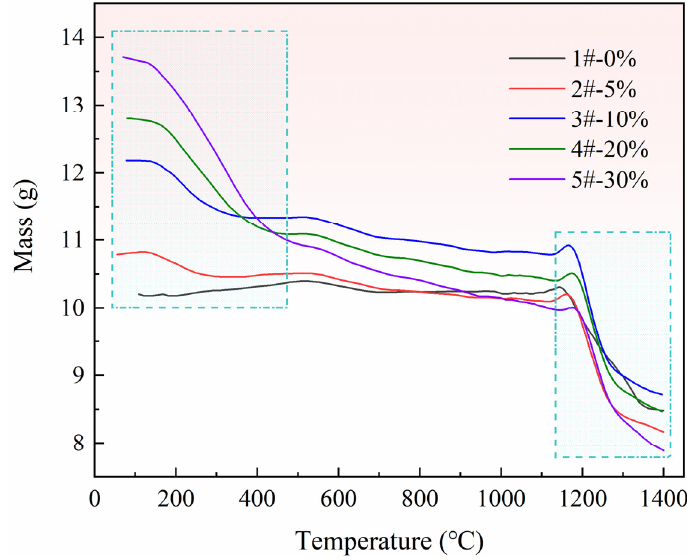
Figure 7. Mass change curves of samples after smoothing.